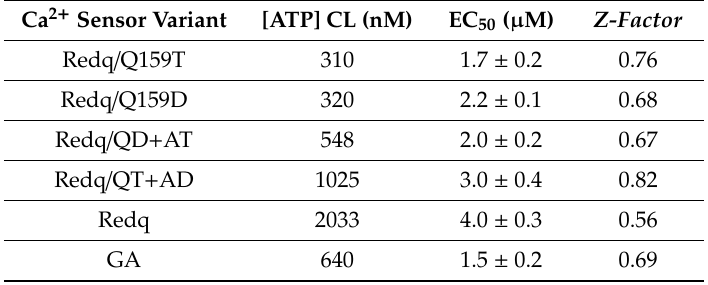
Table 3. Performance of Redquorin mutants in cellular assay for P2Y2 receptor